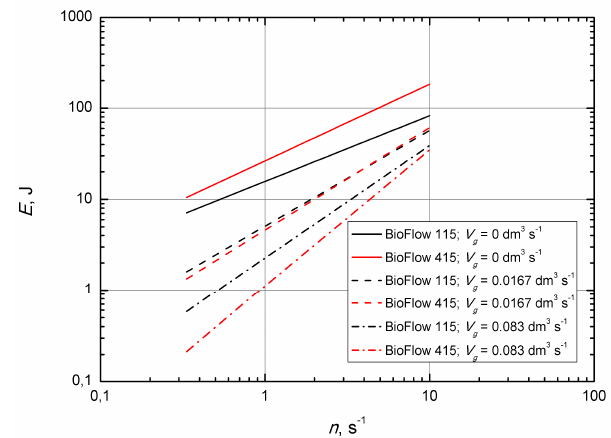
Figure 10. The comparison of the dimensional mixing energy characteristics for the tested bioreactors under ungassed and gassed conditions.